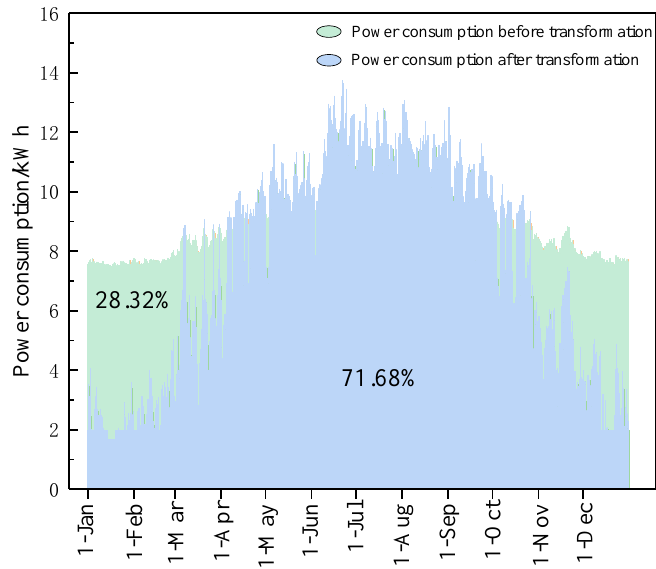
Figure 28. Annual hourly power consumption of DCs before and after the transformation.